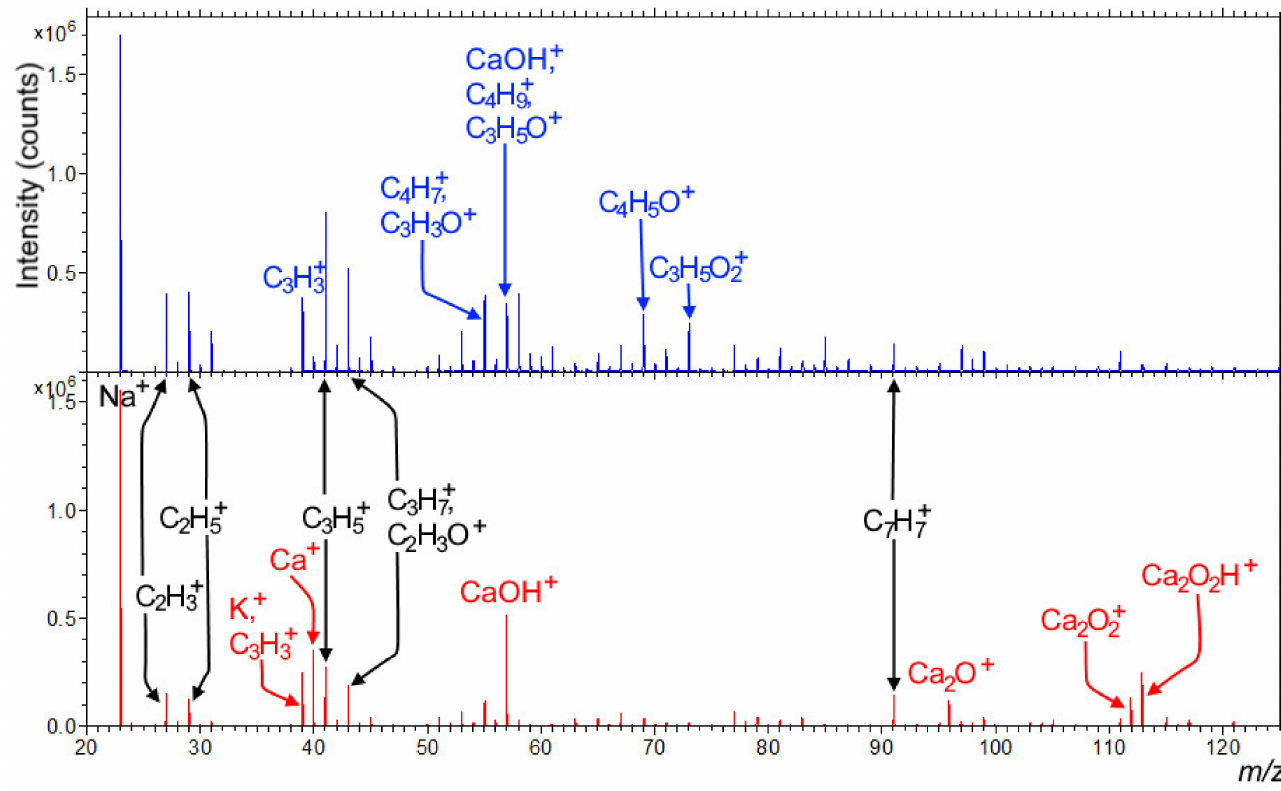
Figure 8. Positive secondary ion spectra of paper 2 ( upper , blue spectrum) and paper 1 ( bottom , red spectrum) in the m/z range from 20 to 125. The most important peaks were assigned with the blue color representing only paper 2, red only paper 1, and black signals equivalently found in both of the